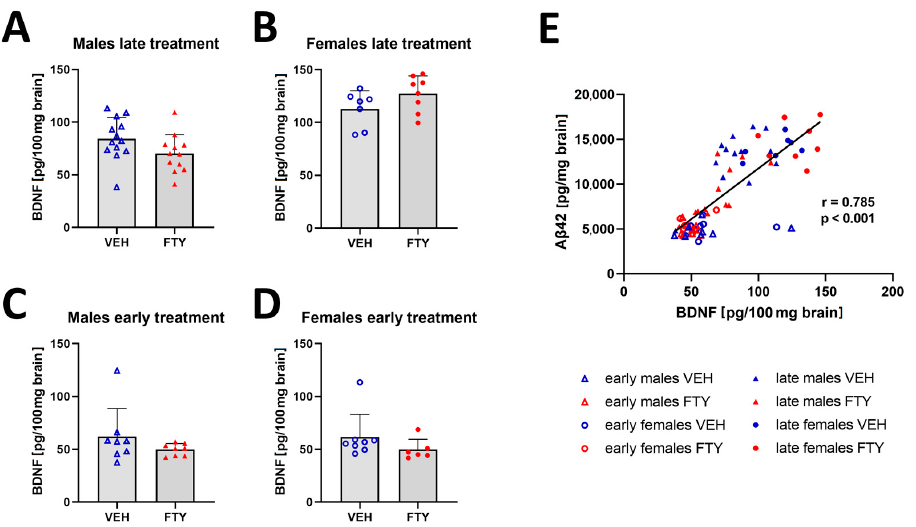
Figure 6. Amount of BDNF in brain tissues. ( A – D ) Graphs show the quantification of BDNF in brain tissues of late treated male ( A ) and female ( B ) and early treated male ( C ) and female ( D ) APPtg mice. ( E ) Linear regression analysis between brain BDNF and A β concentrations show a positive correlation between both of the proteins. Data are presented as mean ± SD; n = 8, except for late treated males VEH, n = 13; FTY, n = 12) and early treated females ( n = 6). Significance between experimental groups was calculated using the Wilcoxon–Mann–Whitney test. Correlation coefficient was analysed using Pearson’s correlation test.